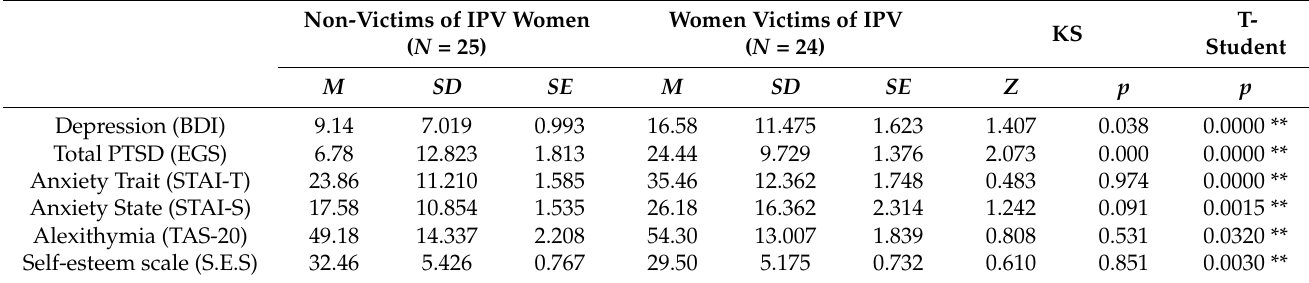
Table 1. Psychological differences between the population of battered women and the population of non-battered